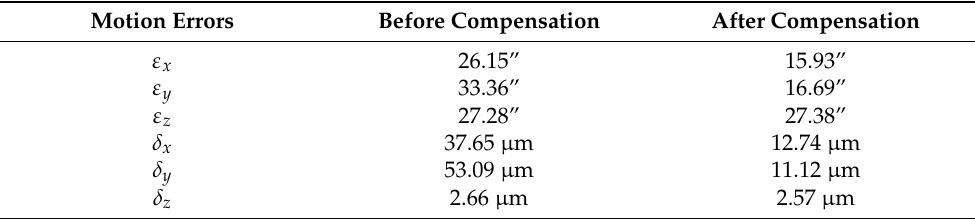
Table 3. The measurement results before and after the compensation of the six DOF motion errors of the rotary